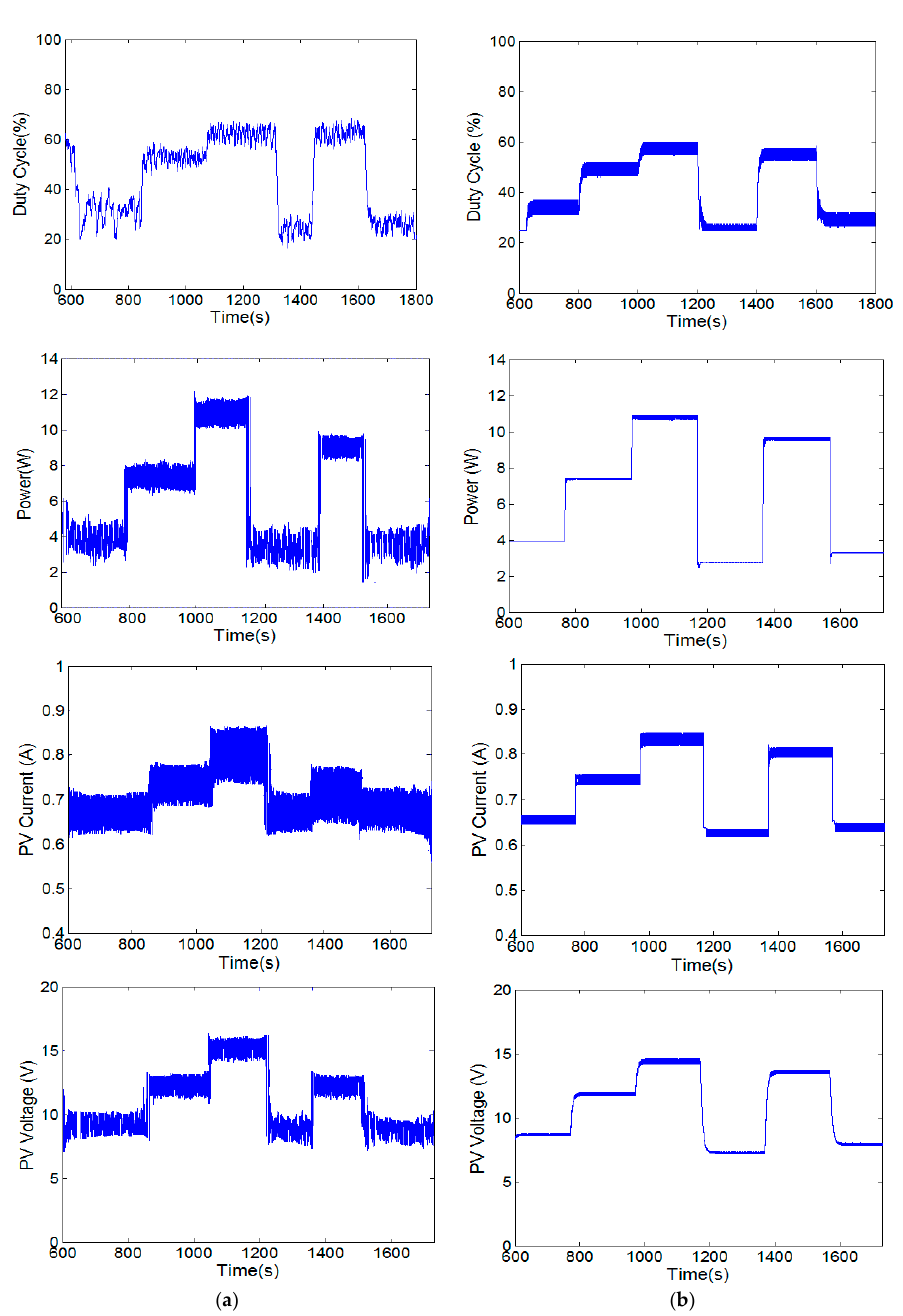
Figure 9. ( a ) Experimental and ( b ) simulated MPPT duty cycle, power, current voltage with IC.